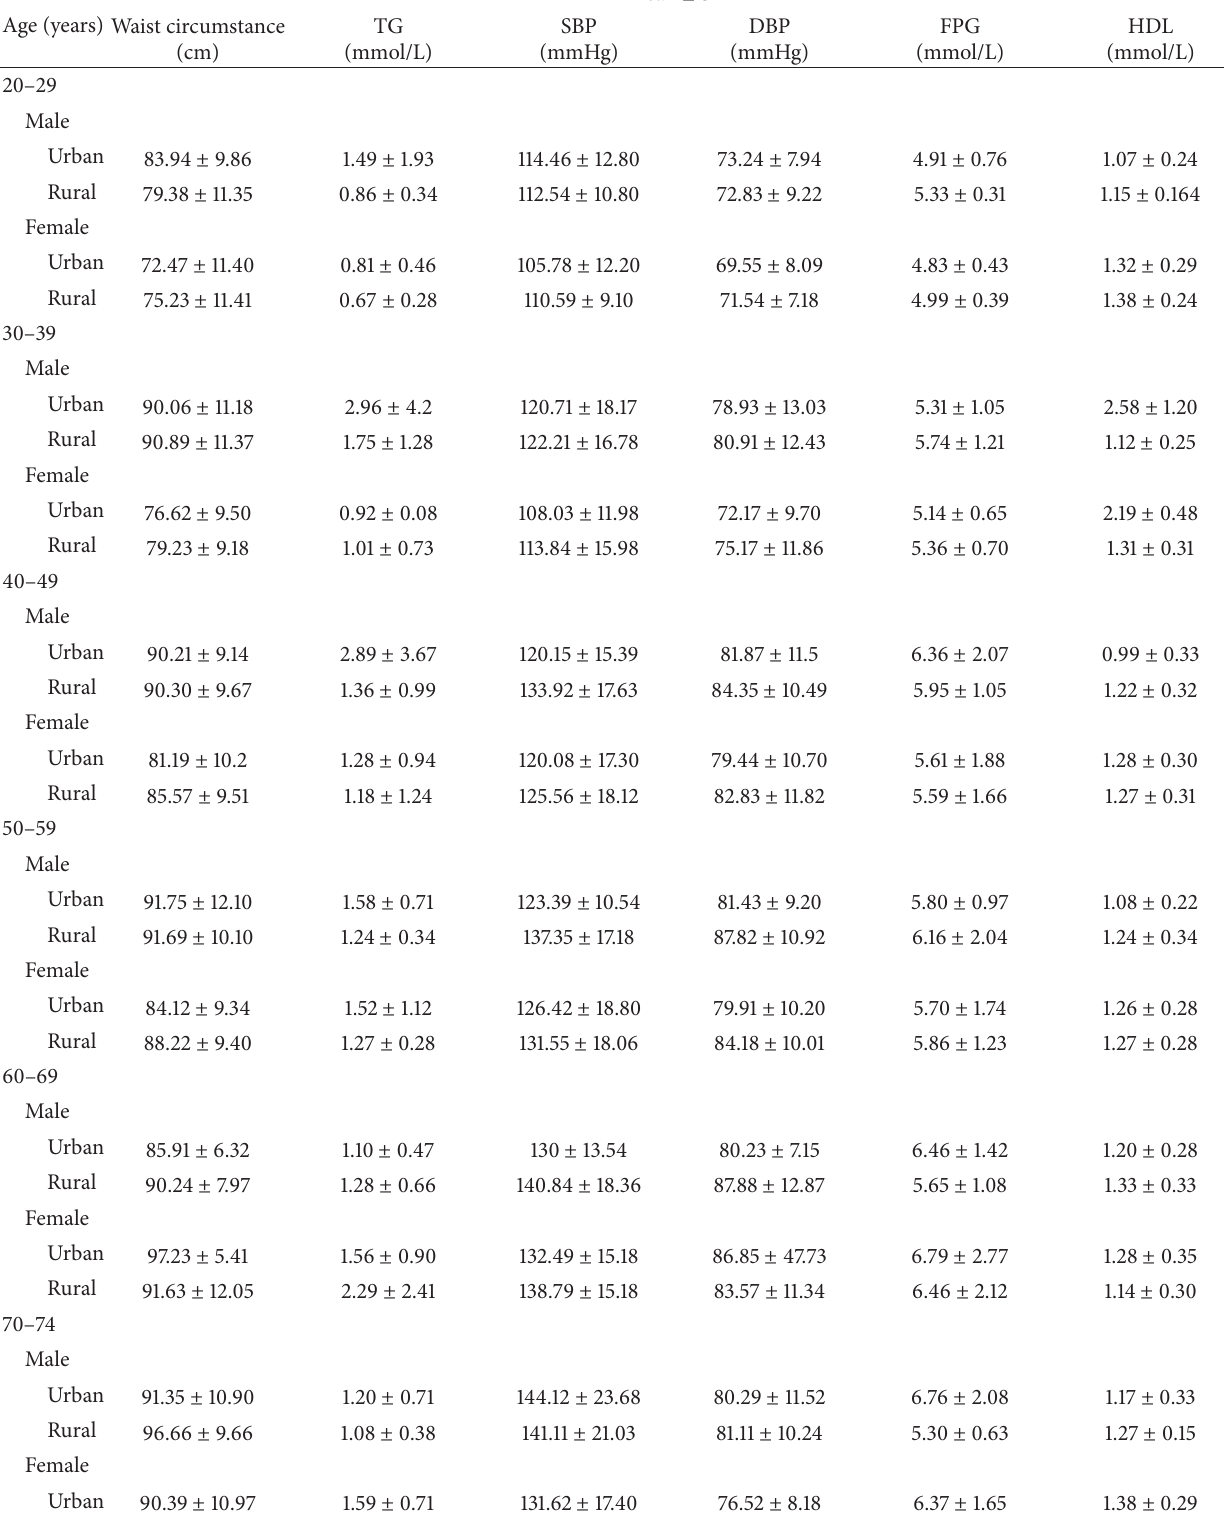
Table 1: General characteristics of study